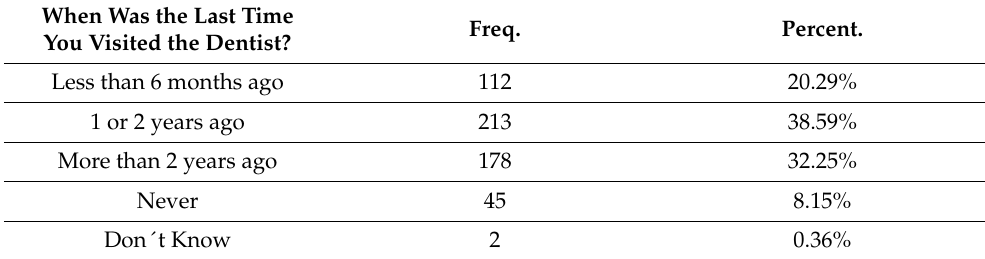
Table 6. Last visit to the dentist.